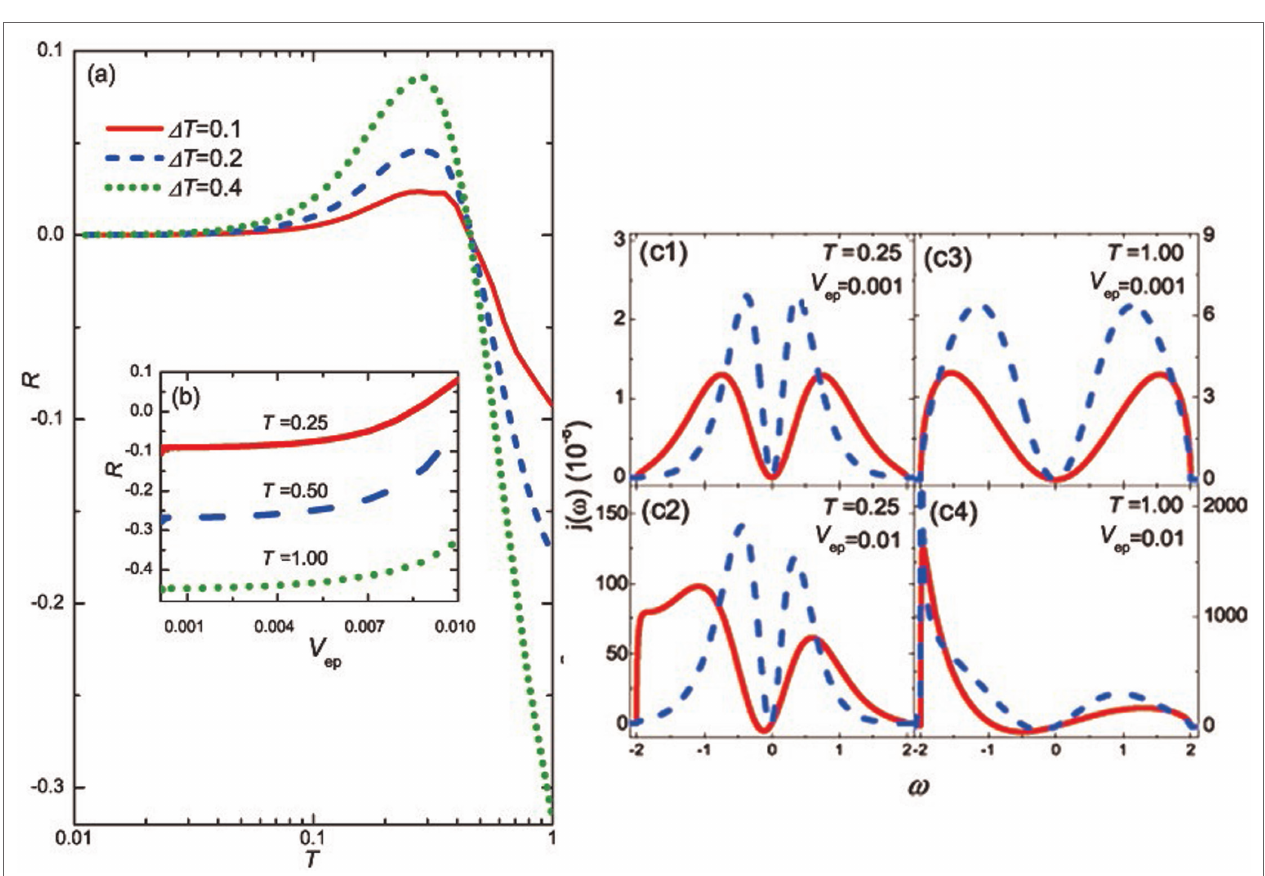
FIGURE 11 | (A) Thermal rectification R through the metal–insulator interface as a function of average temperature T for different temperature differences at electron–phonon interaction V ep = 0.01 (B) Thermal rectification R as a function of the EPI at different temperatures. (C1–C4) Thermal current density j ( ω ) in the backward (dashed lines) and forward (solid lines) transport for various EPI and temperatures. The figure has been adapted with permission from the copyright holder (Institute of Physics), Zhang et al. (2013a).